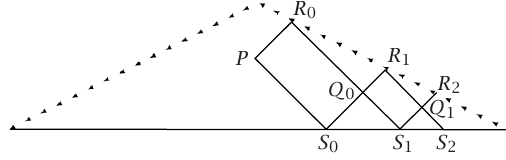
Figure 3.2 . The regions in the definition of H(P ; x,t)